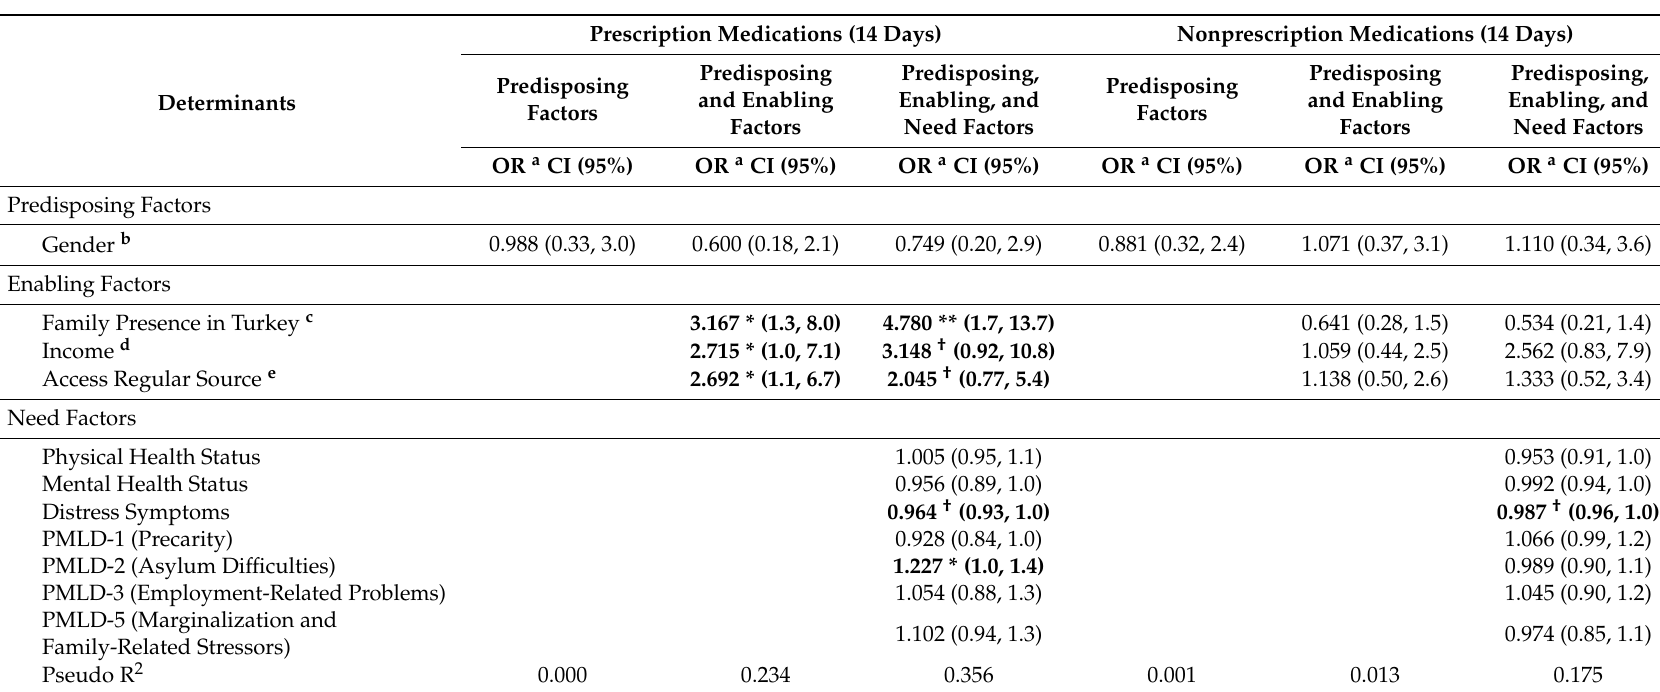
Table 3. Logistic regression analysis showing association between selected determinants and utilization of prescription and nonprescription